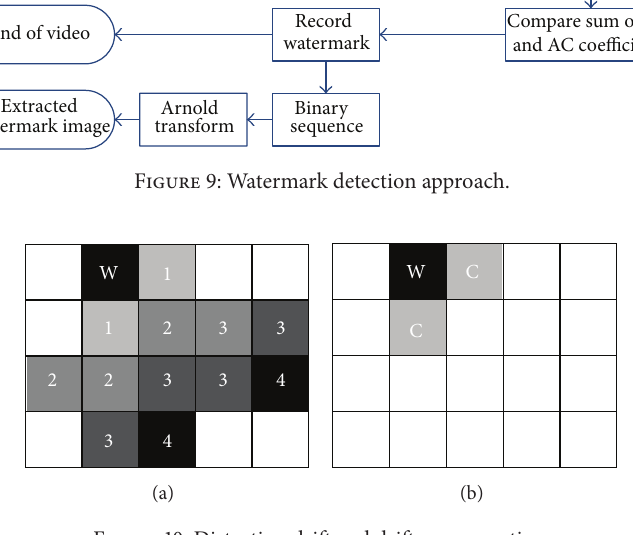
Figure 10: Distortion drift and drift compensation.